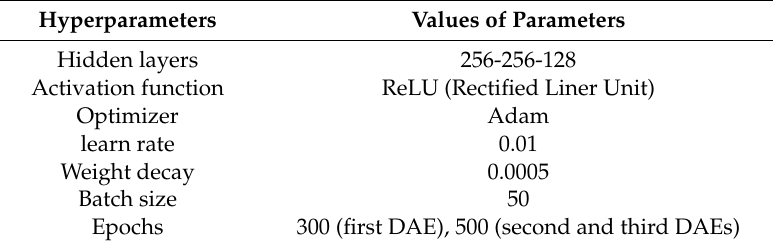
Table 1. Hyperparameters of the network